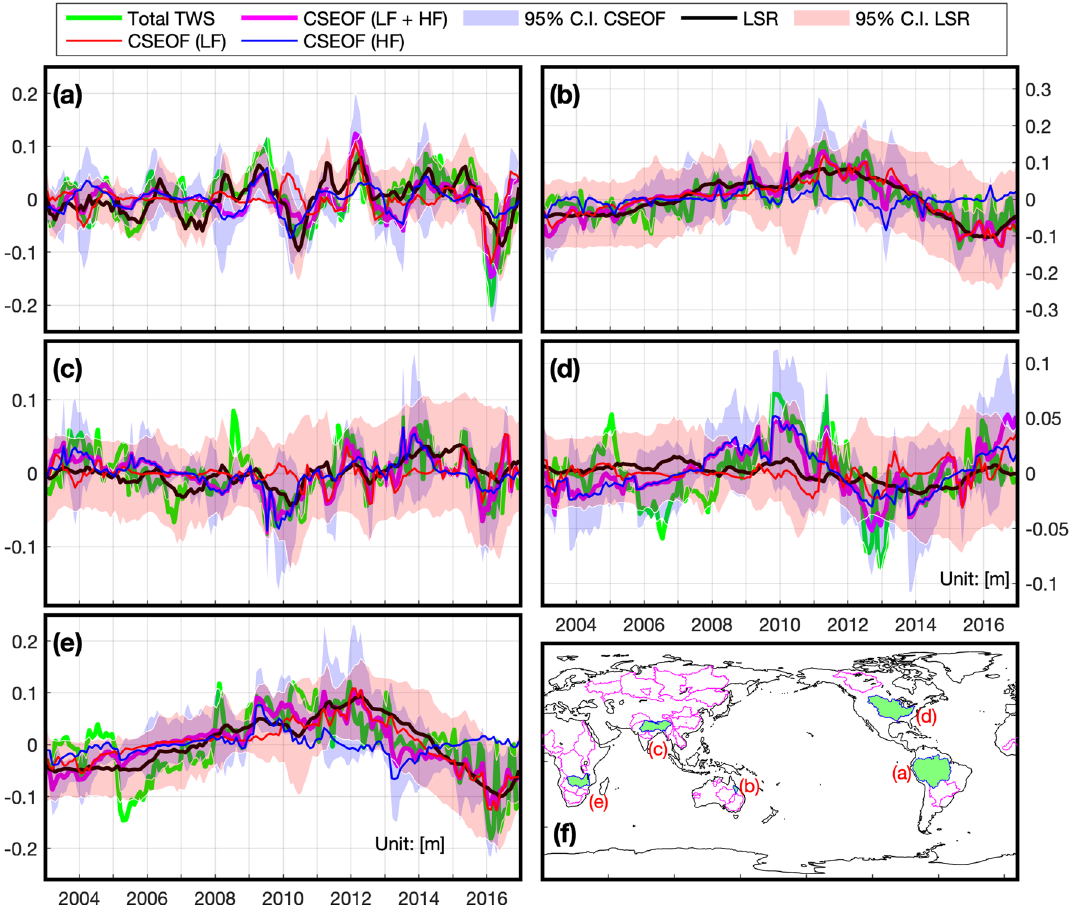
Figure 4. Spatial-mean time-series of regional ENSO-related TWS; ( a ) the Amazon River, ( b ) the Burdekin River, ( c ) the Ganges Brahmaputra River, ( d ) the Mississippi River, ( e ) the Zambezi River, and ( f ) the location of each river-basin (green-filled areas: ( a–e ) and magenta lines: for Table 1); Green: total TWS, Orange: ENSO- related TWS by CSEOF (LF + HF), Black: ENSO-related TWS by LSR, Red: CSEOF LF-mode, Blue: CSEOF HF-mode. The map and graphs were created using MATLAB (version R2020b; https:// www. mathw orks. com/ produ cts/ matlab.